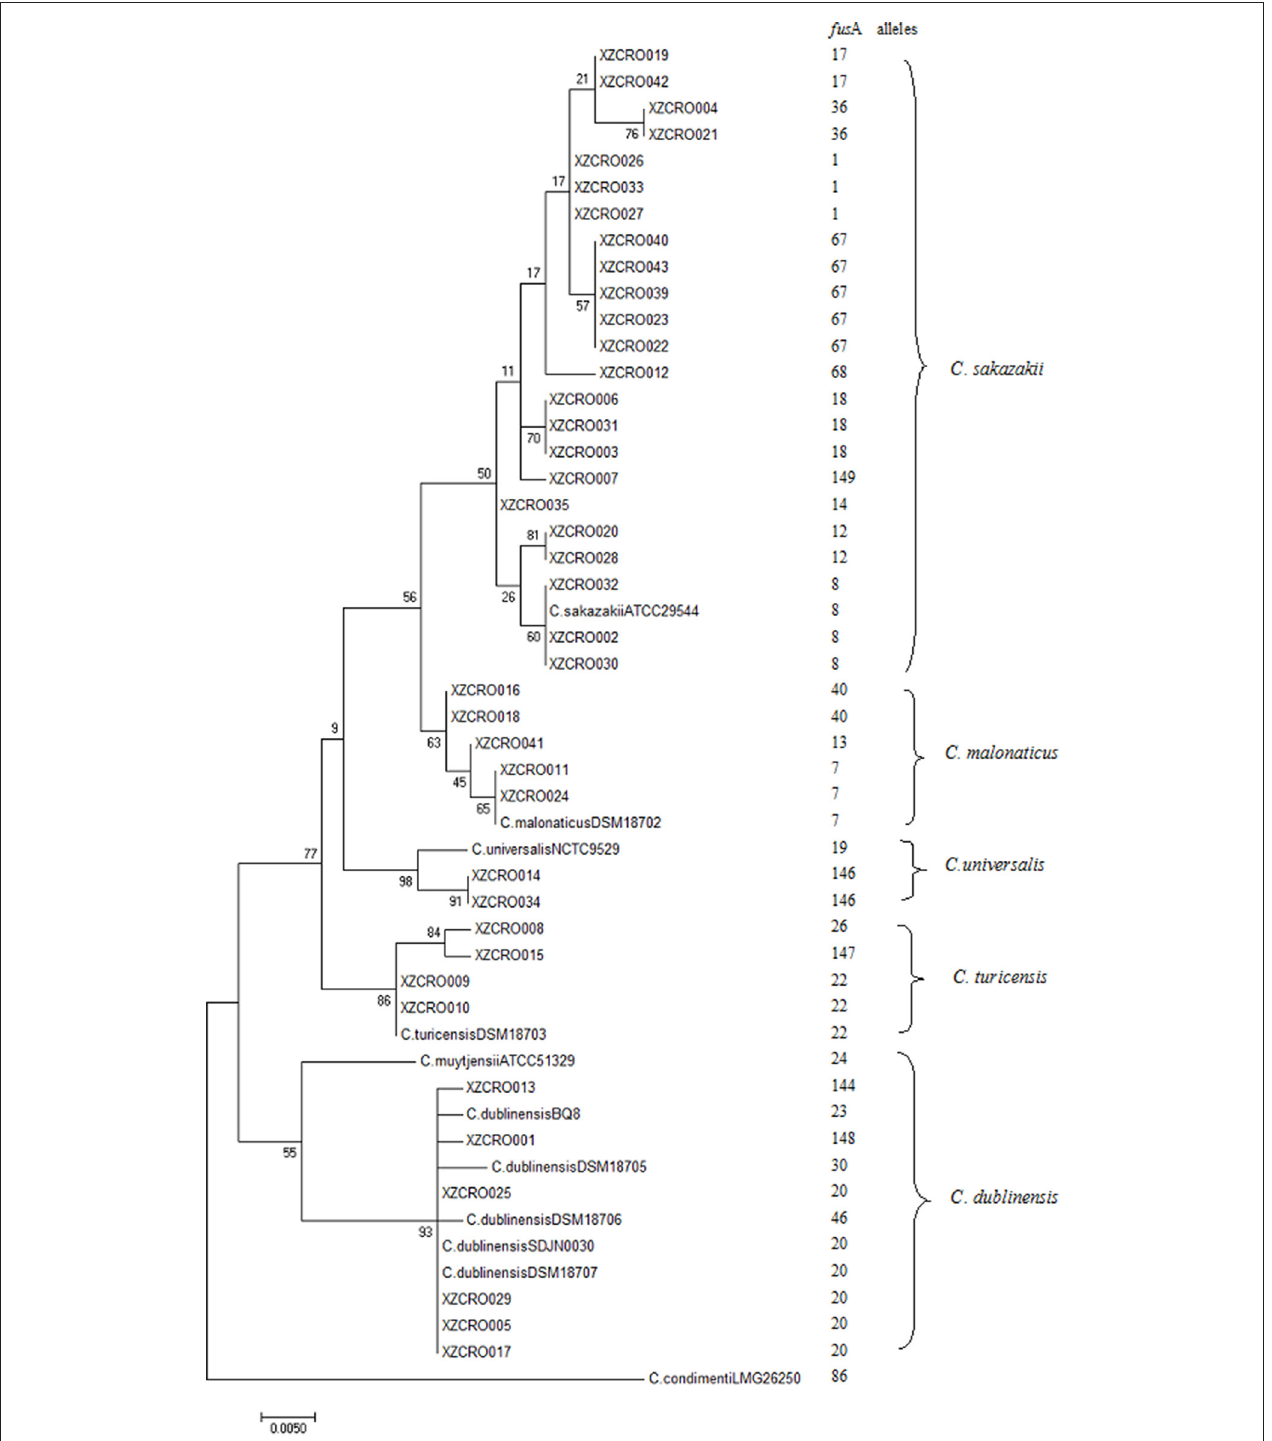
FIGURE 1 | Maximum likelihood tree based on the fus A alleles (438 bp) for the differentiation of Cronobacter species in this study. This tree is drawn to scale using the ClustalX (V.2.0) and the MEGA (v.7.02) with 1,000 bootstrap replicates.